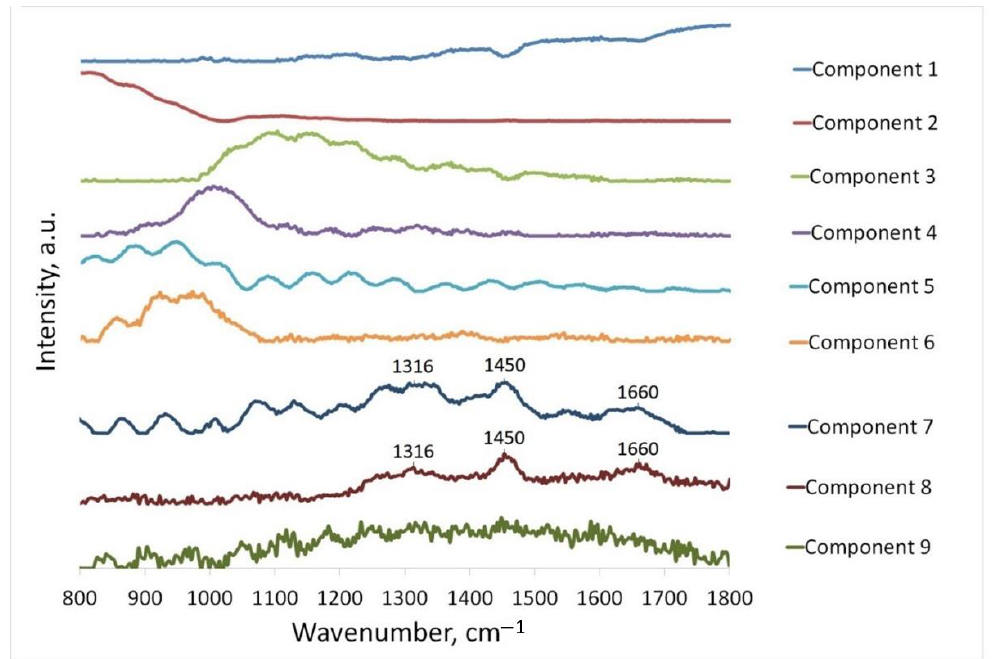
Figure 3. The spectra of skin components (presented in the order they were extracted as a result of MCR-ALS analysis).